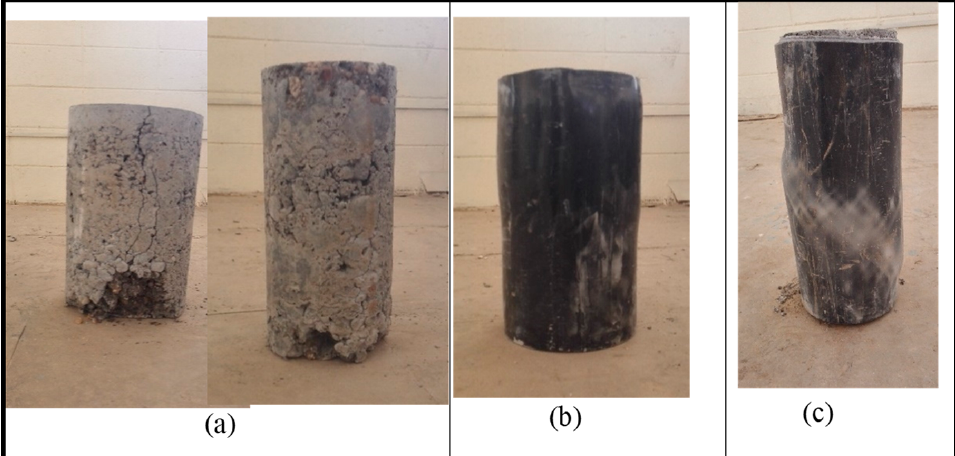
Figure 7. Mode of failure ( a ) unconfined samples ( b ) fully confined samples ( c ) confined with cut ends.